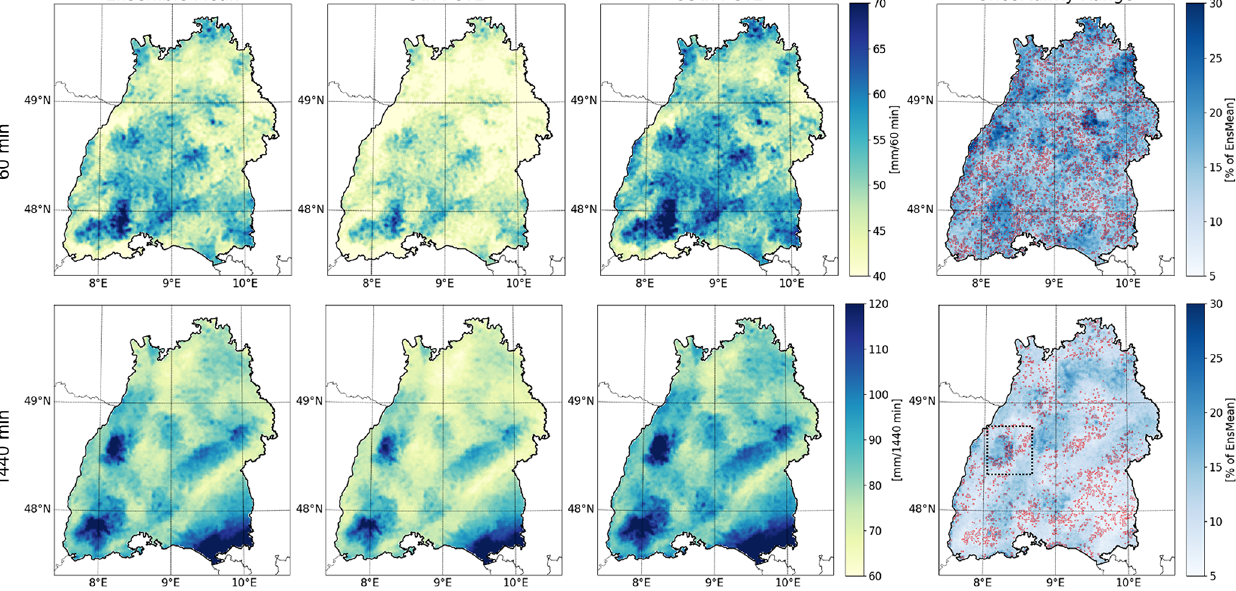
Figure 6. Ensemble mean (left column) and the 5th and 95th percentiles (two middle columns) of a 100-year design storm based on two durations (60min events – upper row; 1440min events – bottom row). Additionally, the ensemble uncertainty range (difference between the 95th and the 5th percentile of the full (bootstrapping and sampling) 5000-member ensemble) is depicted (right column). Regions with a large ( > 65% of the range) contribution of the sampling uncertainty are marked with red. The dashed black square in the panel in the lower right defines the northern Black Forest region discussed in the